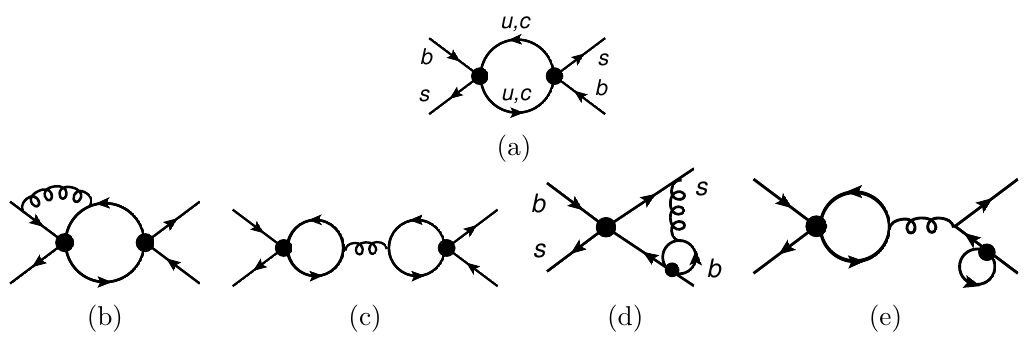
Figure 1 . Sample Feynman diagrams contribution to the process b + ¯ s → ¯ b + s with ∆ B = 1 operators. The latter are marked by a blob. In (a), (b) and (c) both operators can be from the set { Q 1 , . . . , Q 6 } whereas in (d) and (e) one of the operators has to be from the set { Q 3 , . . . , Q 6 }